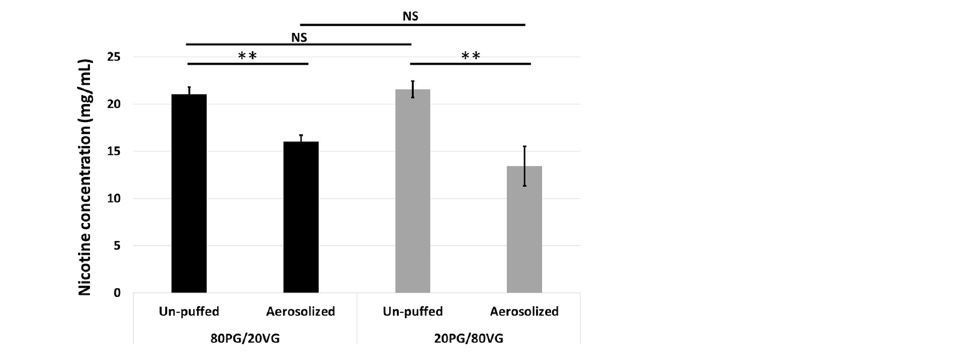
Figure 4. Impact of the PG/VG ratio on the un-puffed and aerosolized nicotine concentration (expressed in mg per mL of refill liquid solution). Experiments were performed in triplicate with a power level fixed at 15 W, a dilution ratio of 1.5 and a same volume of aerosol collected into the cascade impactor for all experimental